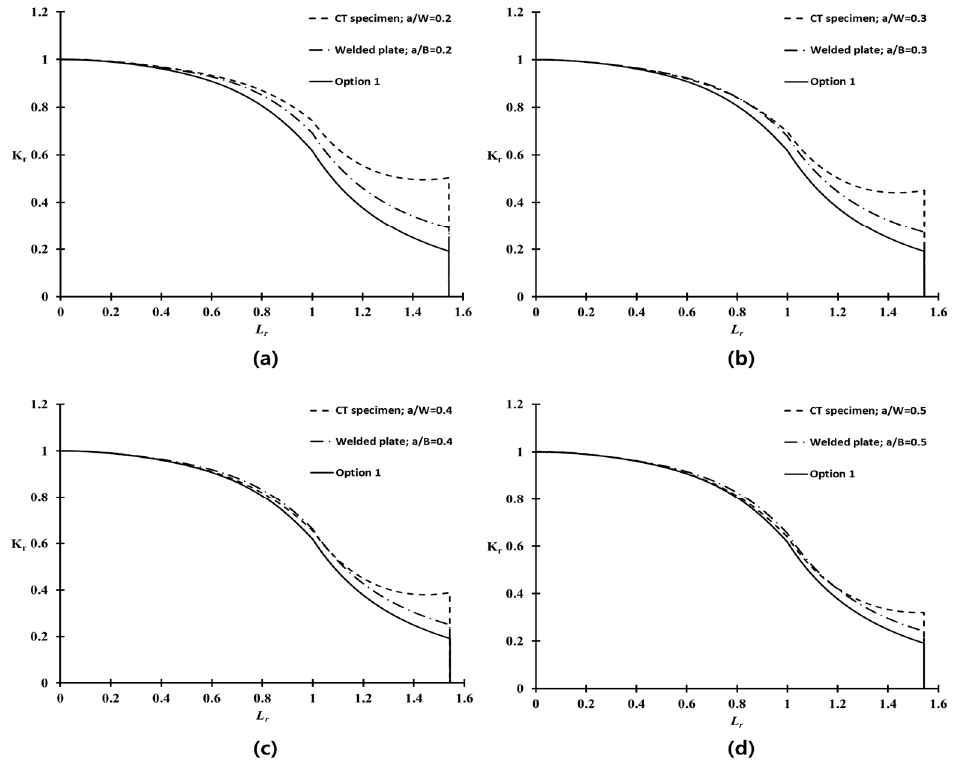
Figure 13. Constraint-based FADs for the welded plate of Al 5083-O with various crack configurations ( a ) a/B = 0.2, ( b ) a/B = 0.3, ( c ) a/B = 0.4, and ( d ) a/B = 0.5.